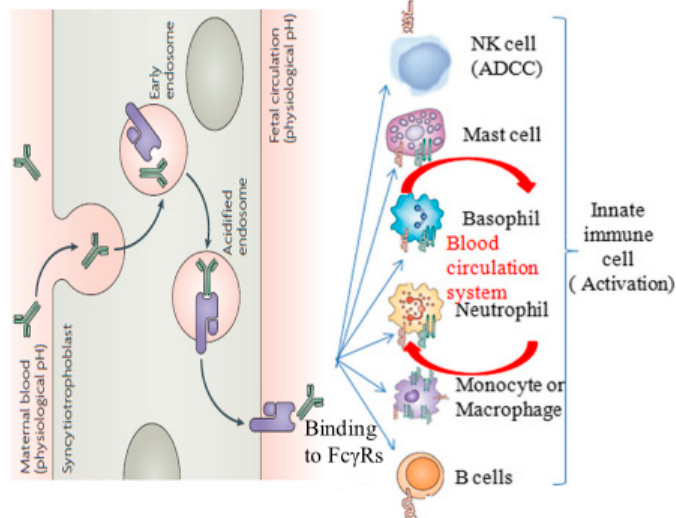
Figure 1. Fc receptor (Fc γ Rn)-mediated immunoglobulin G (IgG) transfer in the human body. Fc γ Rn in intracellular vesicles allows IgG to enter the cell through non-specific liquid endocytosis, and then